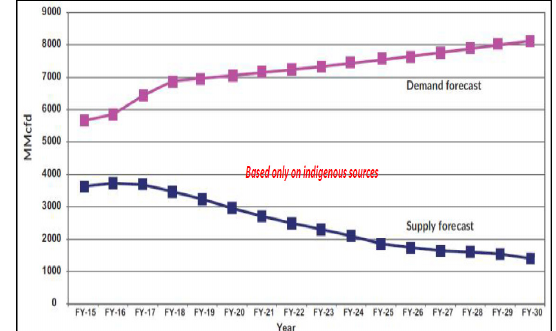
Fig. 2 : The Demand and Supply Forecast of Pakistan